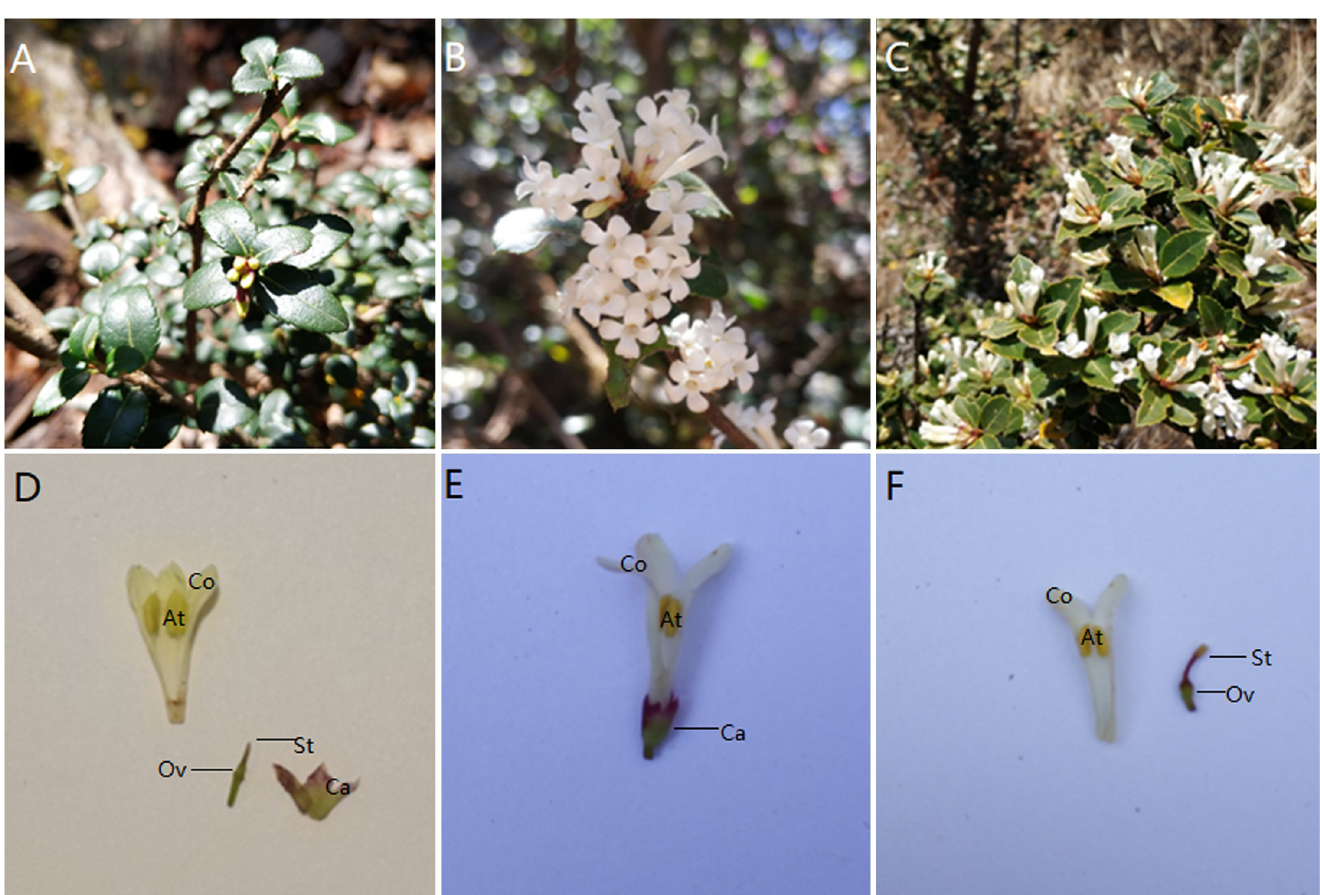
Fig 1. Osmanthus delavayi male and hermaphrodite inflorescence characteristics. Note: (A) Habit of male. (B) Inflorescence of male. (C) Inflorescence of hermaphrodite. (D) Structure of male flower. (E, F) Structure of hermaphrodite flower (At: anther, Ca: calyx, Co: corolla, Ov: ovary, St: stigma.).